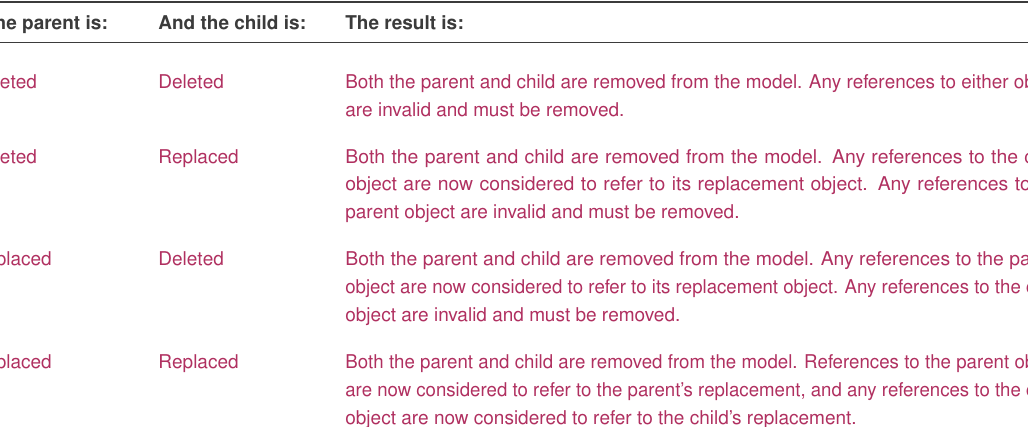
Table 3: The effects of deletions and replacements on nested